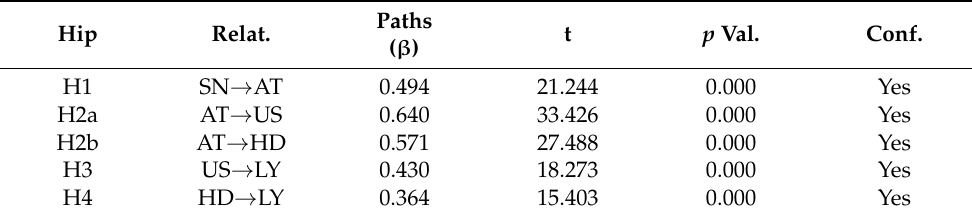
Table 6. Relationship